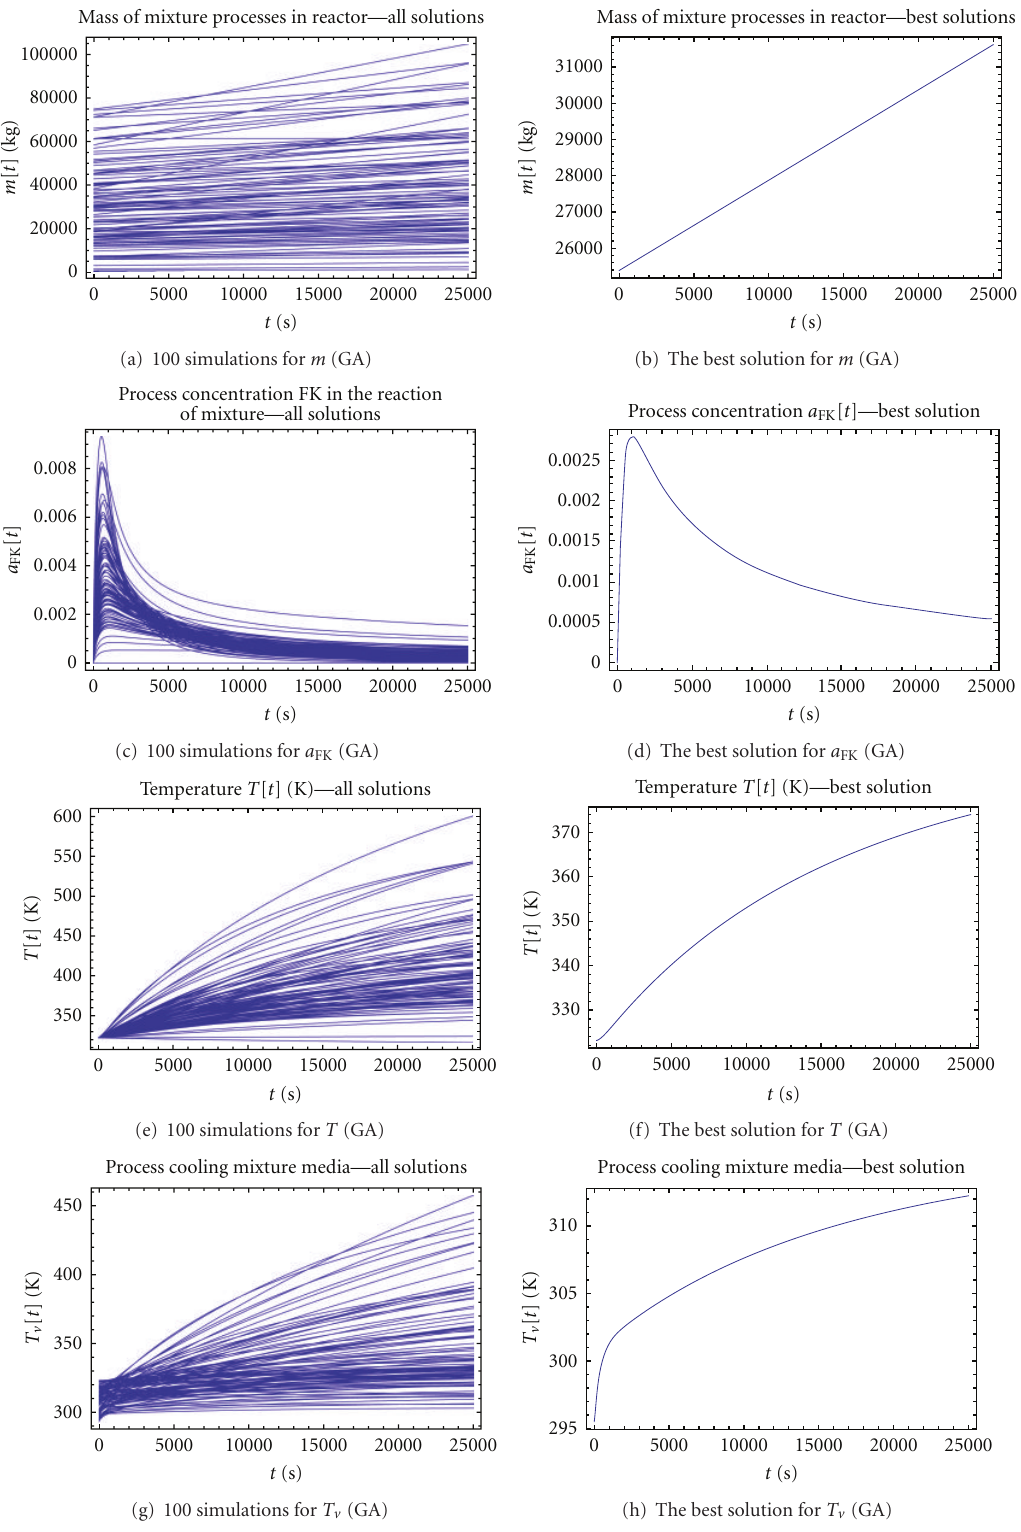
Figure 9: Processes parameters for 100 simulations of